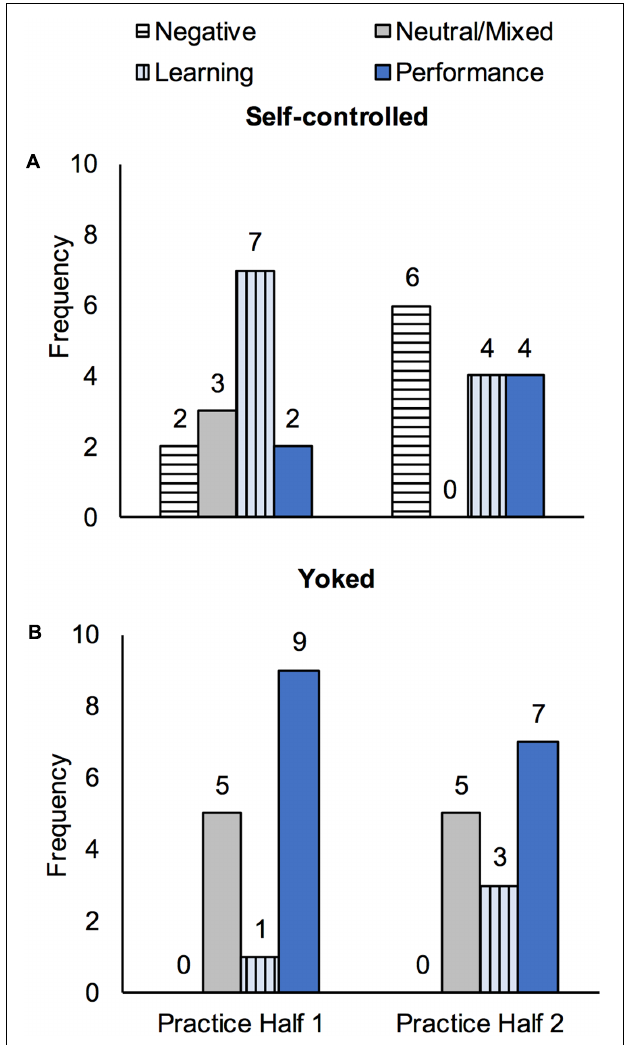
FIGURE 5 | Frequency of each view of haptic assistance (resulting from emergent themes) among Self-controlled (A) and Yoked (B) participants in each half of skill